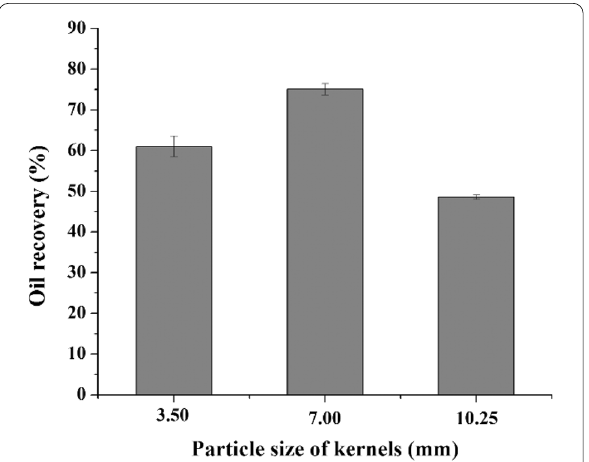
Fig. 1 Oil recovery from rubber seed kernels of different particle